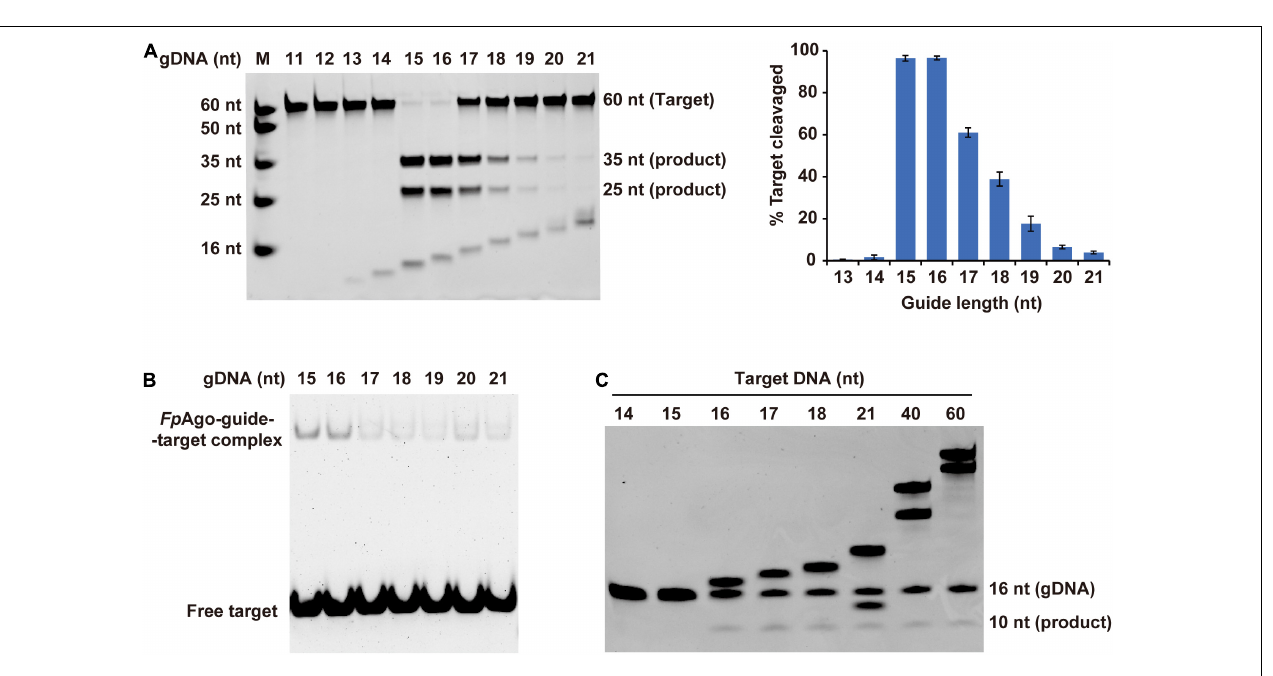
FIGURE 4 | Effect of target and gDNA length on Fp Ago cleavage activity. (A) The gDNAs of 11–21 nt in lengths were tested for cleavage efficiency in vitro . Histogram data were calculated from gels quantitatively analyzed by Quantity One software. Error bars represent the SD of three independent experiments. (B) The affinities of Fp Ago form binary complexes with different length of 5 (cid:48) -P guide DNAs. (C) Minimum size of target used by Fp Ago. ssDNA targets of 14–18, 21, 40, and 60 nt in lengths were tested for cleavage efficiency in vitro . All cleavage experiments were carried out at the 1:5:2 molar ratio (400 nM Fp Ago: 2000 nM